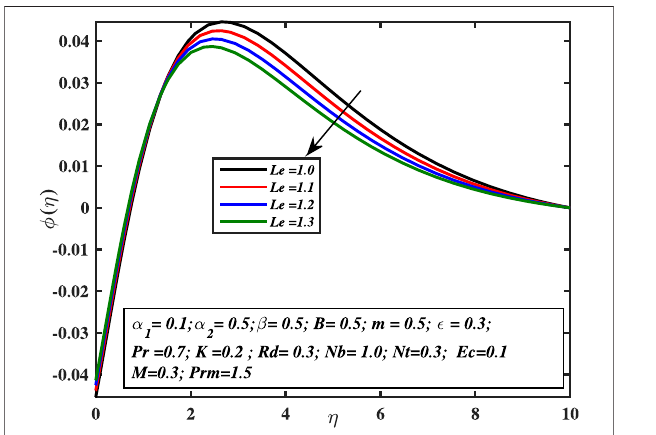
FIGURE 15 | Effect of Le on the ϕ ( η ) pro fi le.